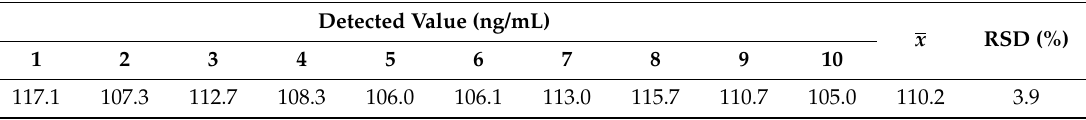
Table 3. Results of the accuracy experiment on ITG (n = 10).